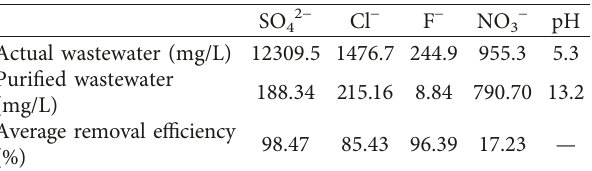
Figure 11: The effect of precipitated solid reuse. Table 3: Results of anion removal.